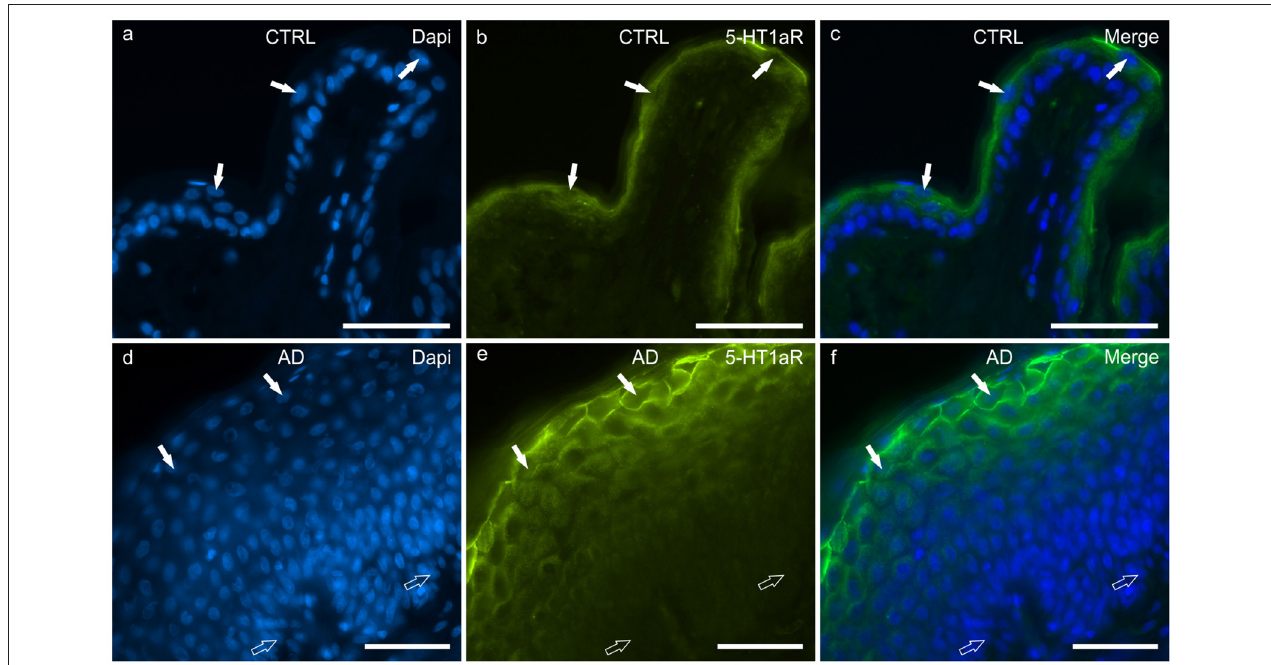
FIGURE 7 | Photomicrographs of cryosections of canine skin showing showing serotonin 1a receptor (5HT1aR) immunoreactivity (IR) in the tissues of the healthy dogs (CTRL) (a–c) and in the dogs with atopic dermatitis (AD) (d–f) . (a–c) The white arrows indicate the DAPI-labeled nuclei of some keratinocytes of the suprabasal layer showing bright 5-HT1aR-IR. (d–f) In the AD dogs, the cell membrane of the more superficial keratinocytes showed very bright 5-HT1aR-IR whereas the germinative cells of the basal layer and the deepest cells of the suprabasal layer were either nearly 5-HT1aR negative or expressed very faint 5-HT1aR-IR. Bar, 50 µ